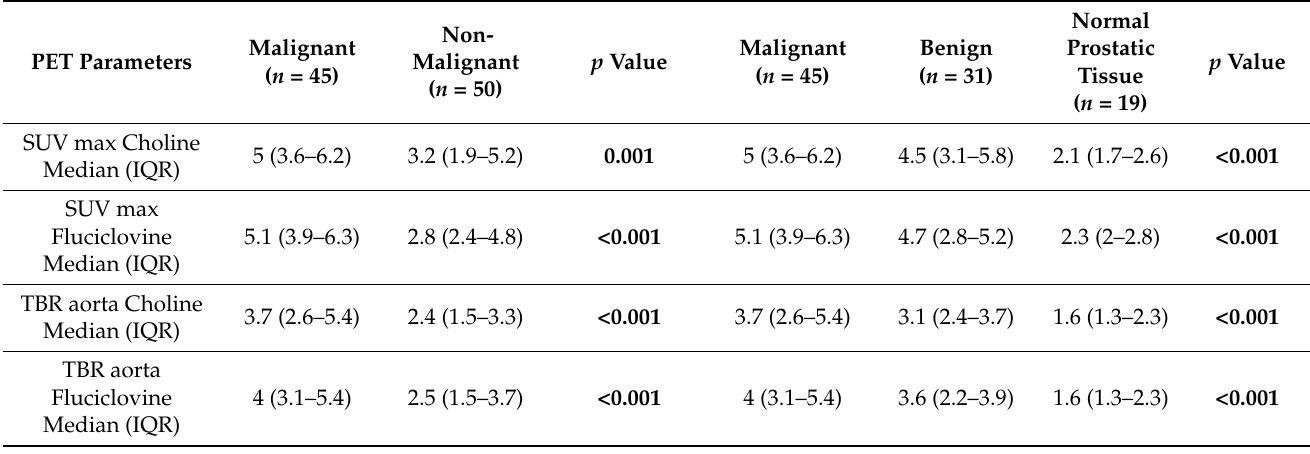
Table 3. Semi-quantitative PET parameters in malignant vs. non-malignant lesion and malignant lesion vs. benign lesion vs. normal prostatic tissue, considering final pathologic examination as reference standard (lesion-based analysis; n = 95).